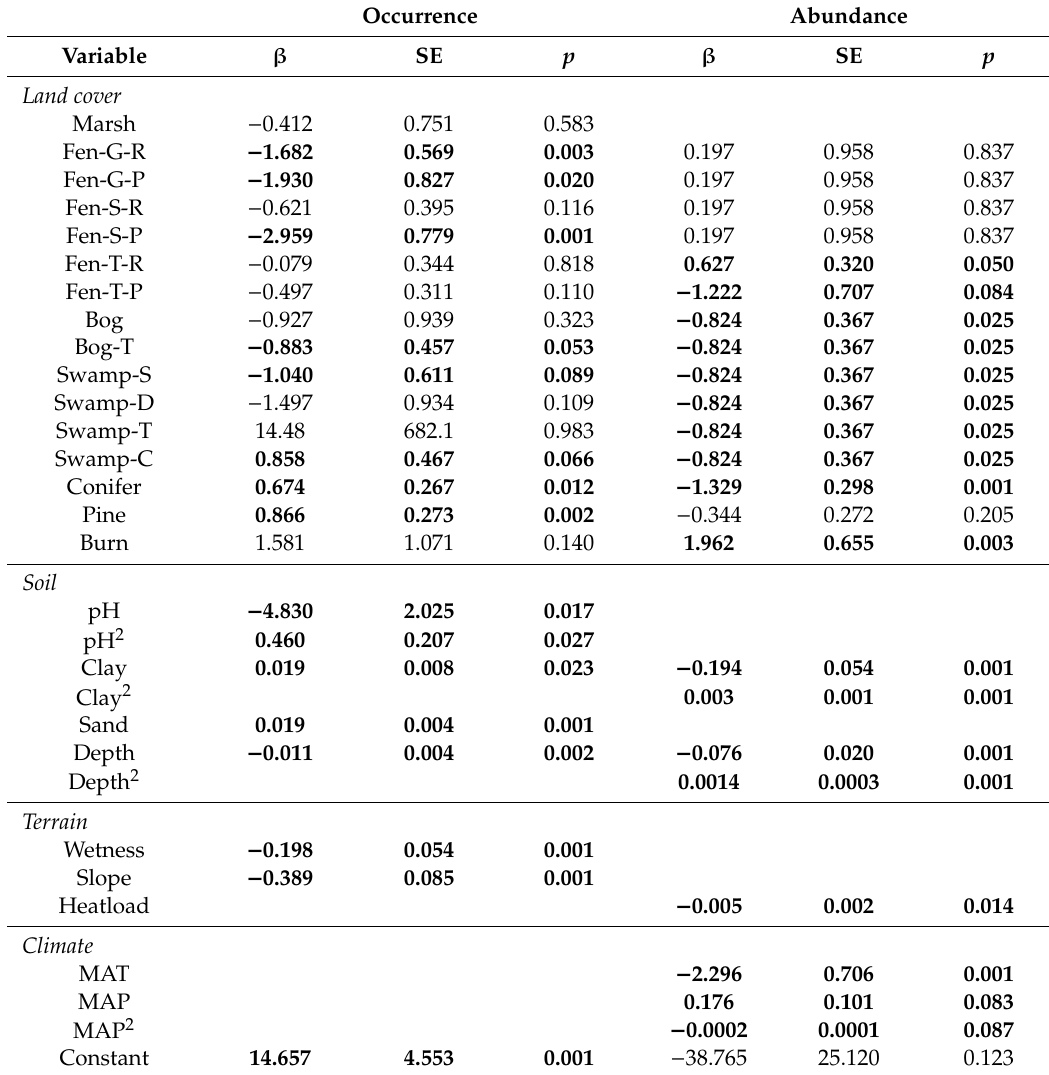
Table A2. Model results describing blueberry shrub occurrence using logistic regression and shrub abundance using fractional logistic regression. Model coe ffi cients ( β ), standard errors (SE), and significance ( p ) reported for each model. Significant variables ( p < 0.1) have parameters in bold font. Note the same values for some fens and bog / swamps in abundance models as those land cover categories were combined and fit as single